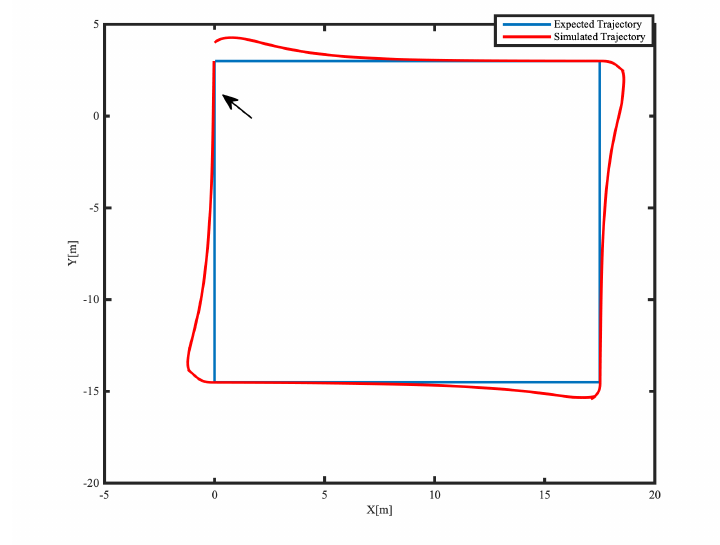
Figure 9. The biomimetic spherical robot trajectory tracking on a xoy plane-Case